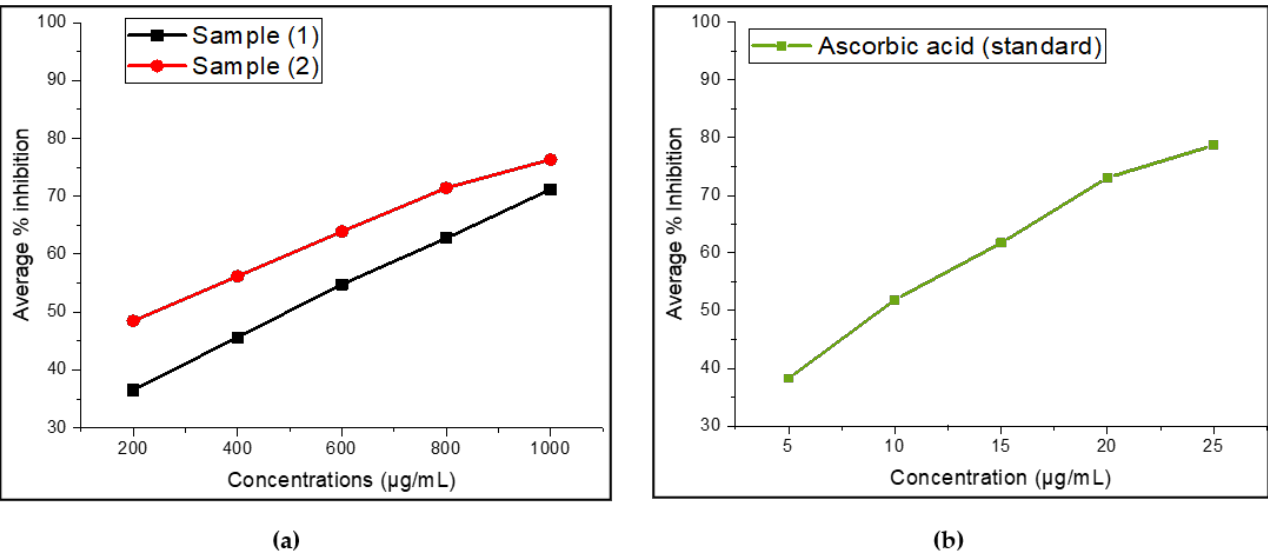
Figure 4. Average percentage of free-radical scavenging activity by DPPH assay ( n = 3). (a) Essential oils from majorana species (S 1 oils from majorana species (S 1 and S 2 ); ( b ) standard reference (ascorbic and S 2 ); (b) standard reference (ascorbic acid).